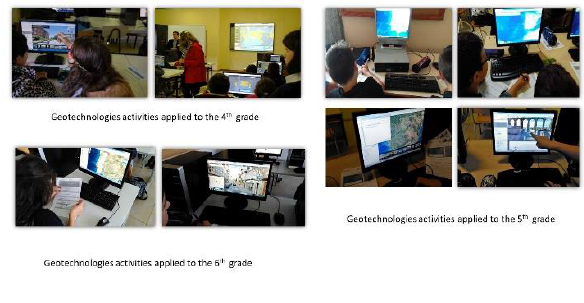
Figure 7: Pictures from classroom learning experiences.